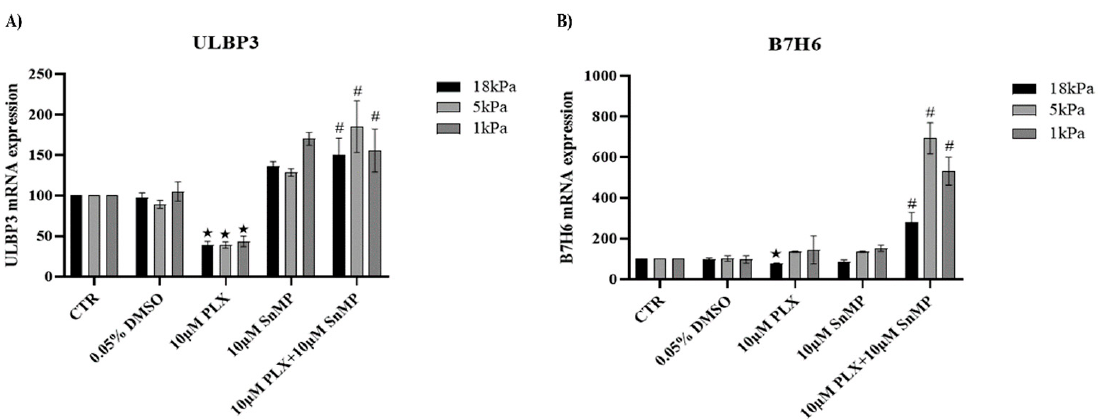
Figure 4. mRNA expression of ULBP3 and B7H6 in MeOV-1 cells co-treated with PLX4032 and SnMP. ULBP3 ( A ) and B7H6 ( B ) mRNA expression was assessed by qPCR in MeOV-1 cells cultured under standard culture conditions (18 kPa O 2 ) or adapted for 5 days to 5 kPa or 1 kPa O 2 . Cells were then exposed to 10 µ M PLX4032 ± 10 µ M SnMP for 24 h. Data shown are representative of 2 or 3 independent experiments for each experimental condition. Date denote mean ± S.E.M., (cid:70) p < 0.05 vs. CTR and DMSO; # p < 0.05 vs. PLX4032.